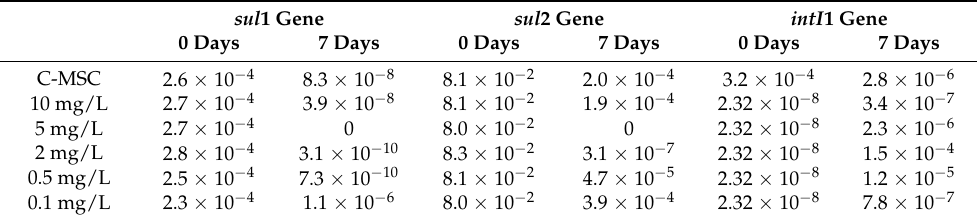
Table 2. SMX-ARGs ( sul 1 and sul 2) and intI 1 gene relative abundances at days zero and seven for each SMX concentration in MSC-experiment and control